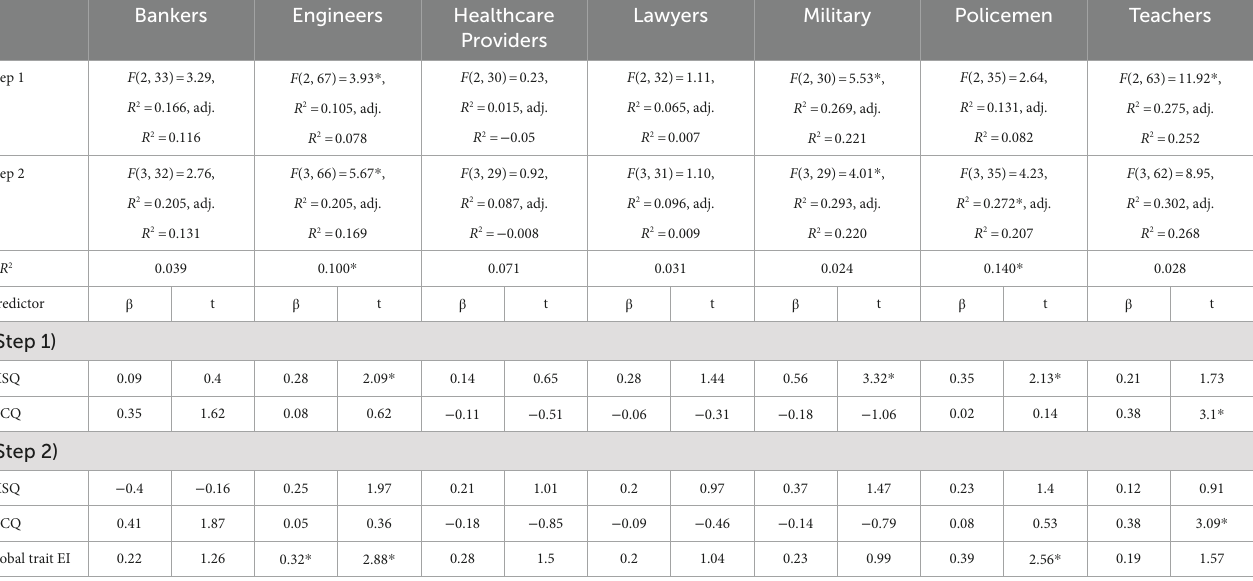
TABLE 4 Hierarchical multiple linear regression